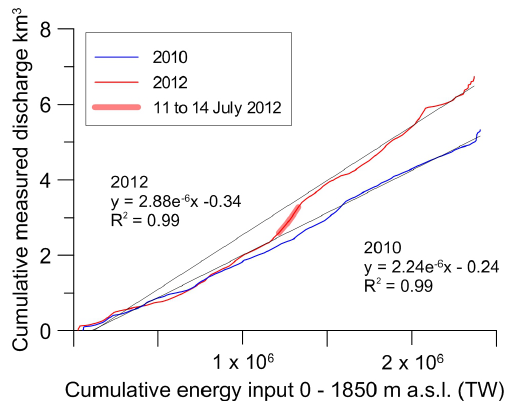
Figure 4. The cumulative measured discharge as a function of the calculated energy input for the catchment up to 1850ma.s.l. The flooding period of 11 to 14 July is marked with a bold red